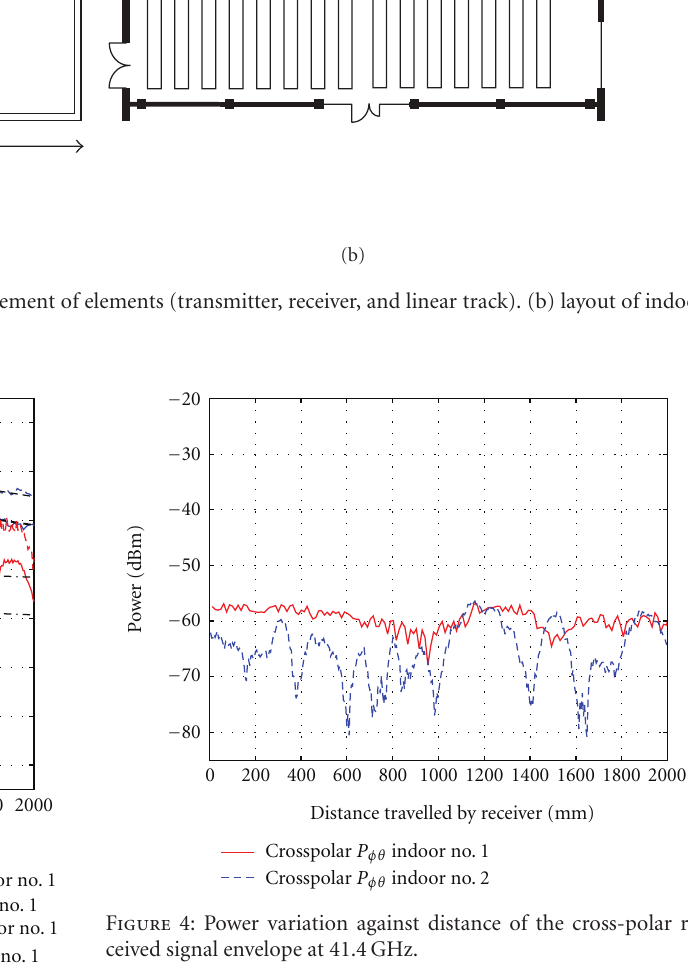
Figure 3: Power variation against distance of the copolar received signal envelope at 41.4 GHz and power decay law fitting.